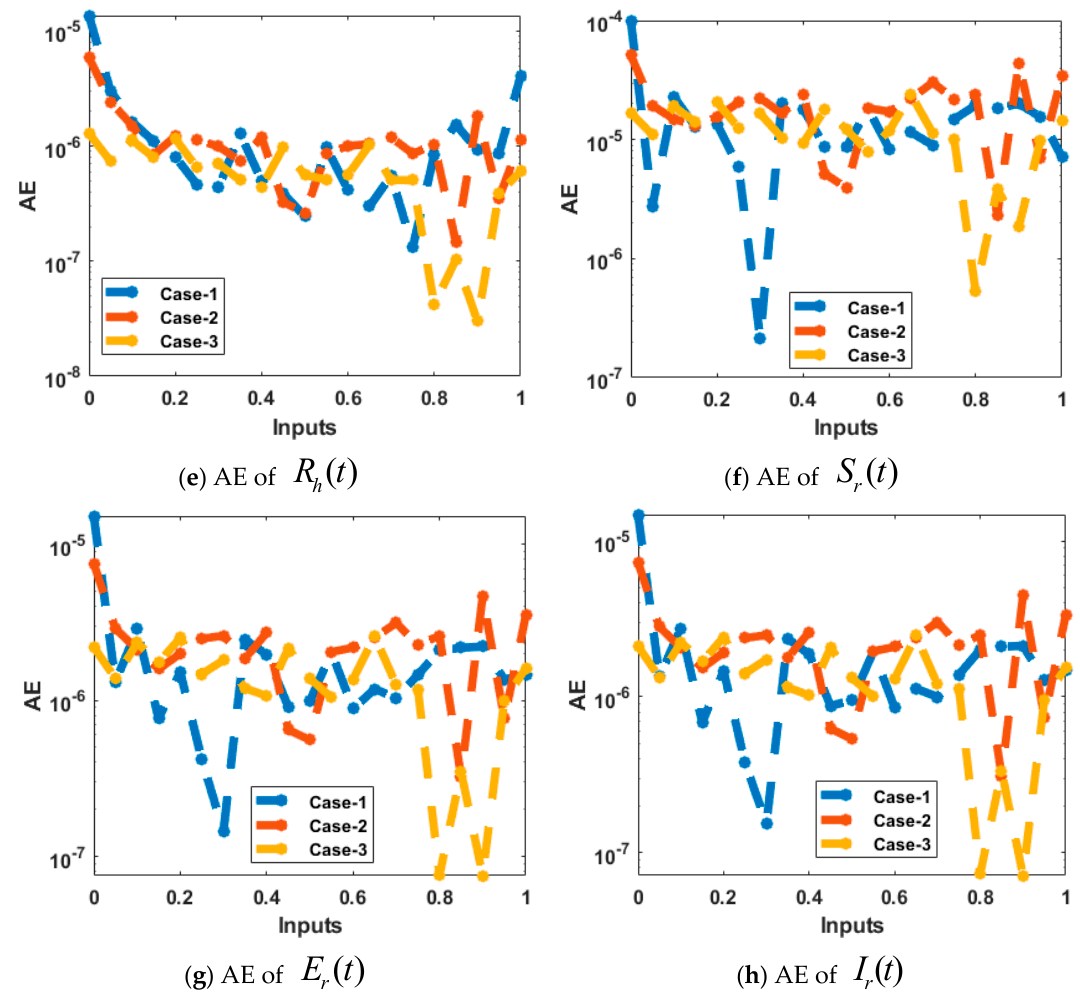
Figure 7. AE performances to solve the fractional monkeypox model.